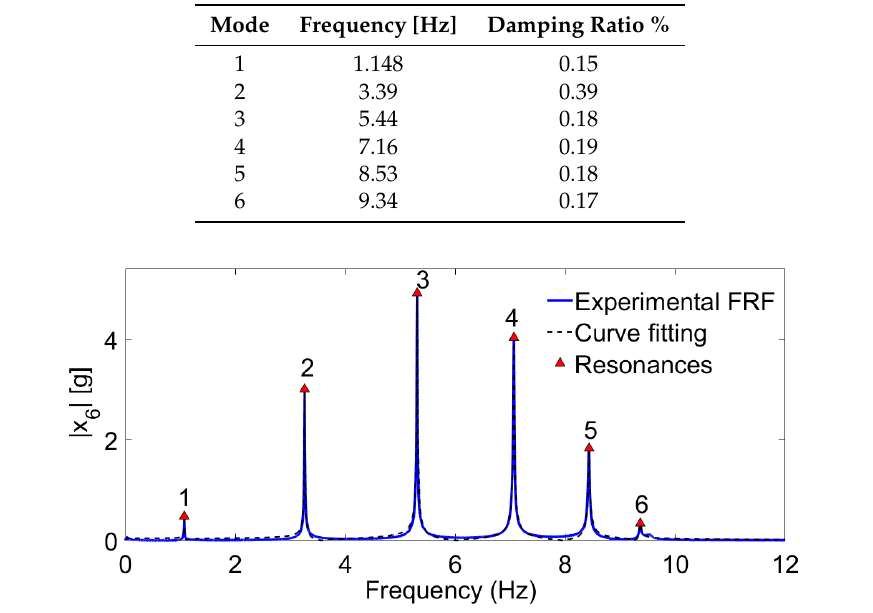
Figure 4. Experimental frequency response function (FRF) of the main system discretized in six dof.